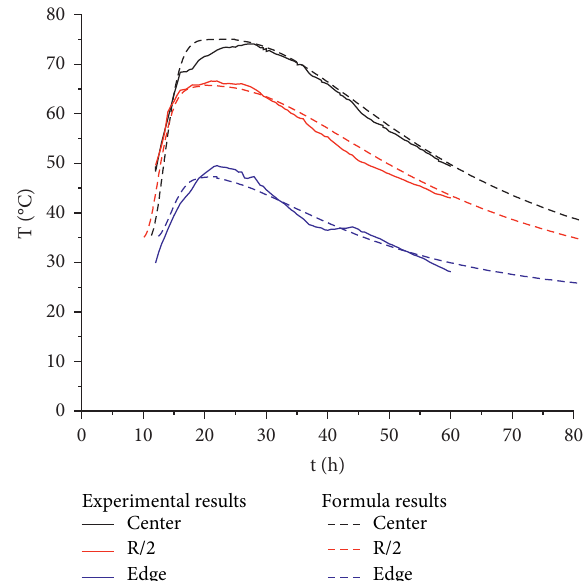
Figure 17: Comparison of formula-calculated results with the experimental results from Gao